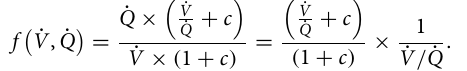
The constant c was calculated from a venous blood gas sample [ c = σ CO 2 × R × T × ( 1 + K c ) ] as a function